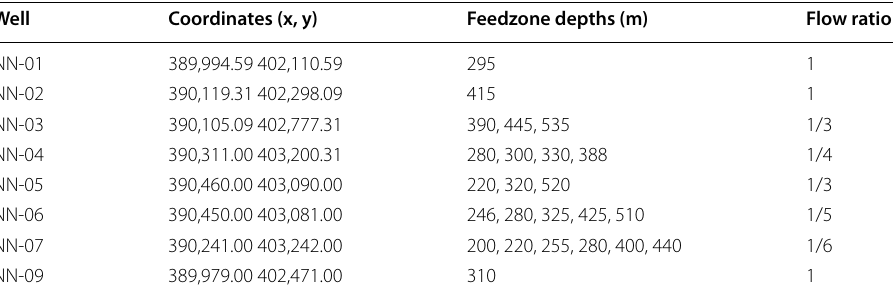
Table 1 Location and depth of the feedzones in each reinjection well. Reinjected fluid is assumed to be evenly divided between each of the